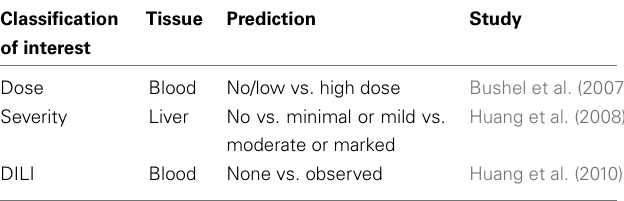
Table 1 | Summary of predictive transcriptomics